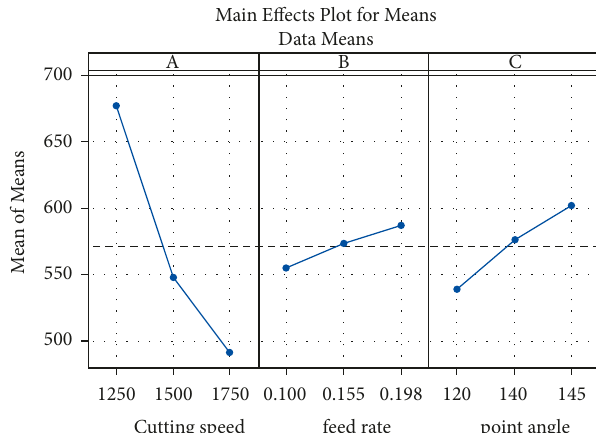
Figure 1: Main effects plot for means: cutting force.